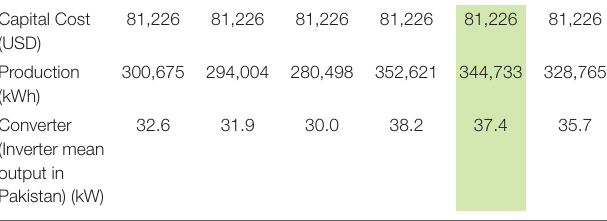
TABLE 5 | Cost and production details of PV panels and converters for Pakistan.